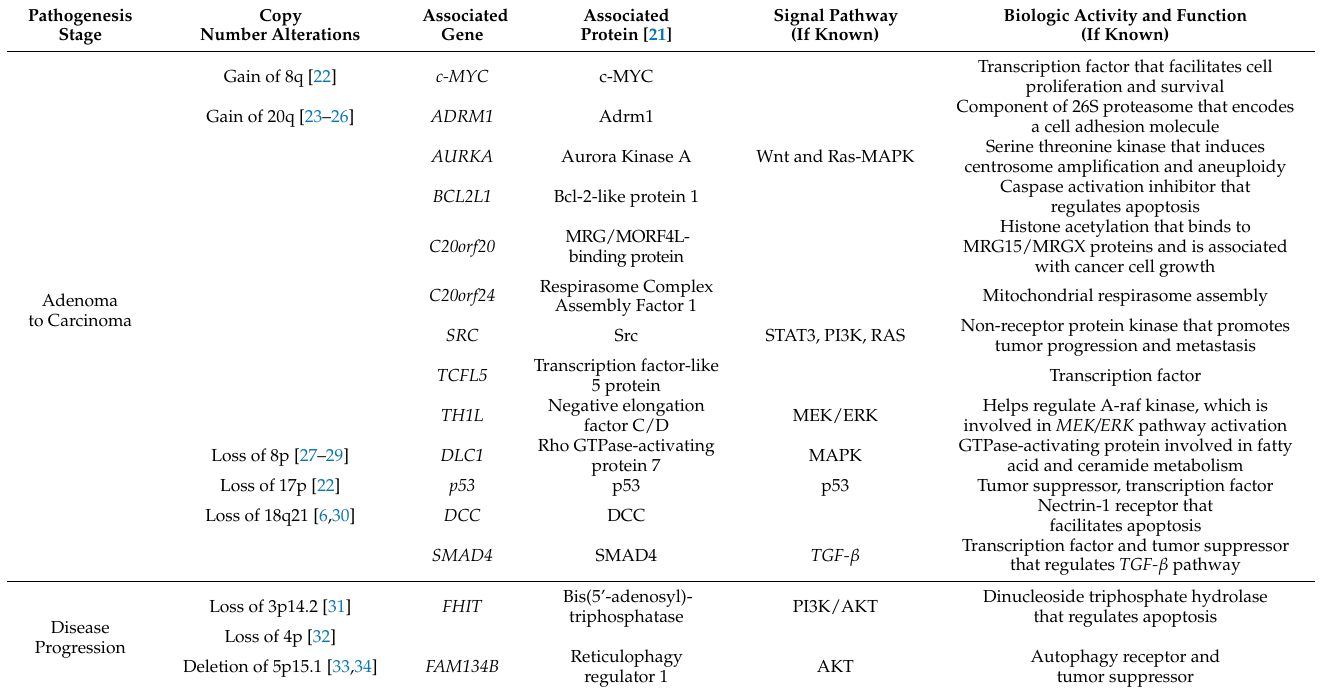
Table 1. Copy number alterations with associated genes and functions in the pathogenesis of colorectal